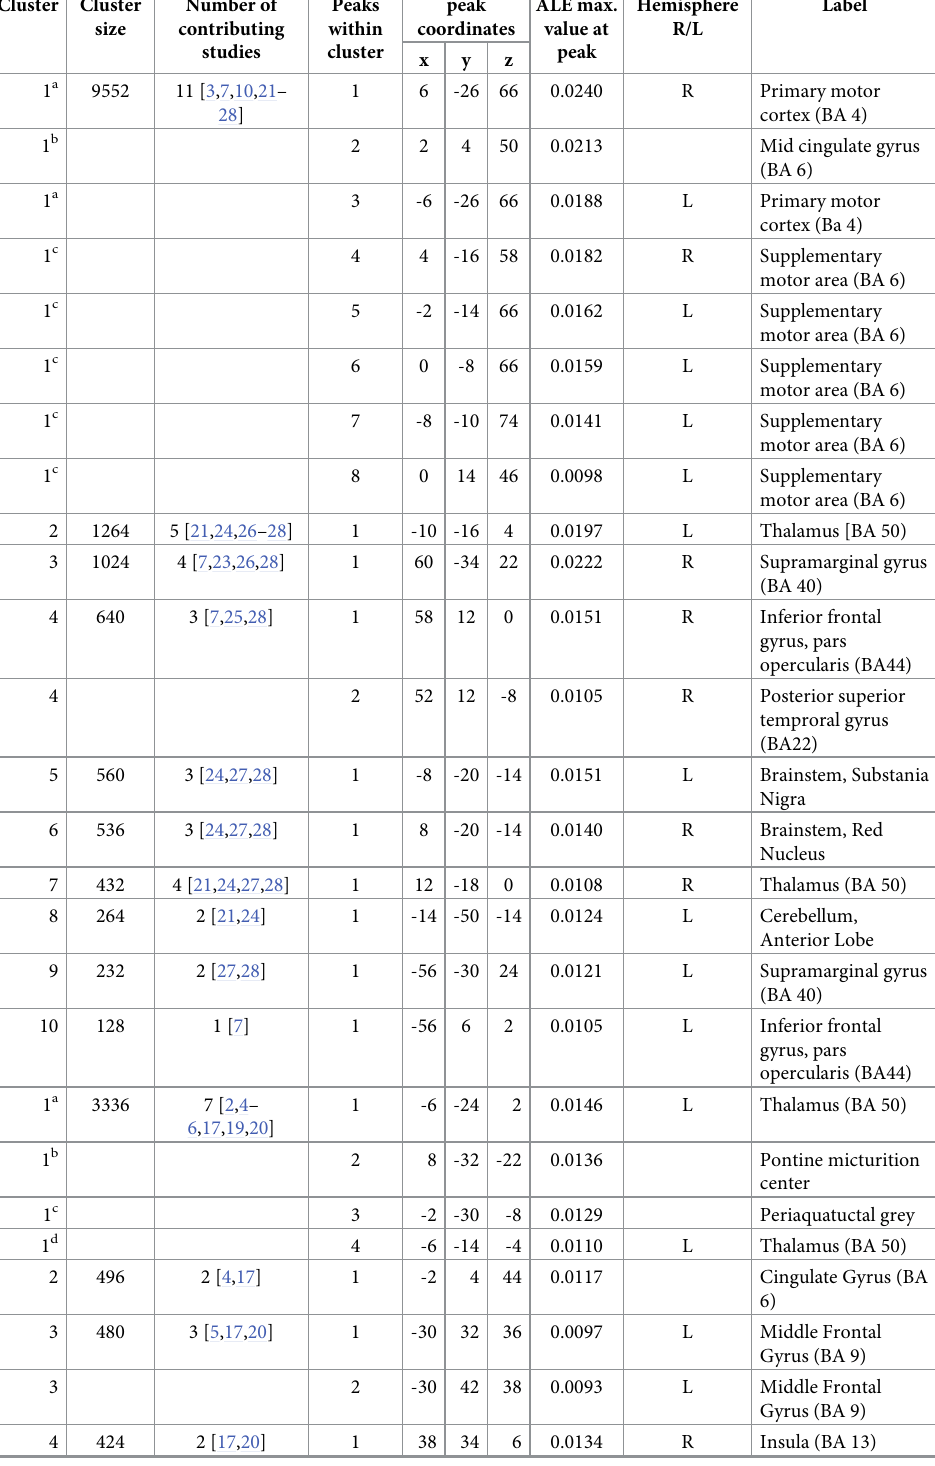
Table 4. ALE results of PFMC and micturition